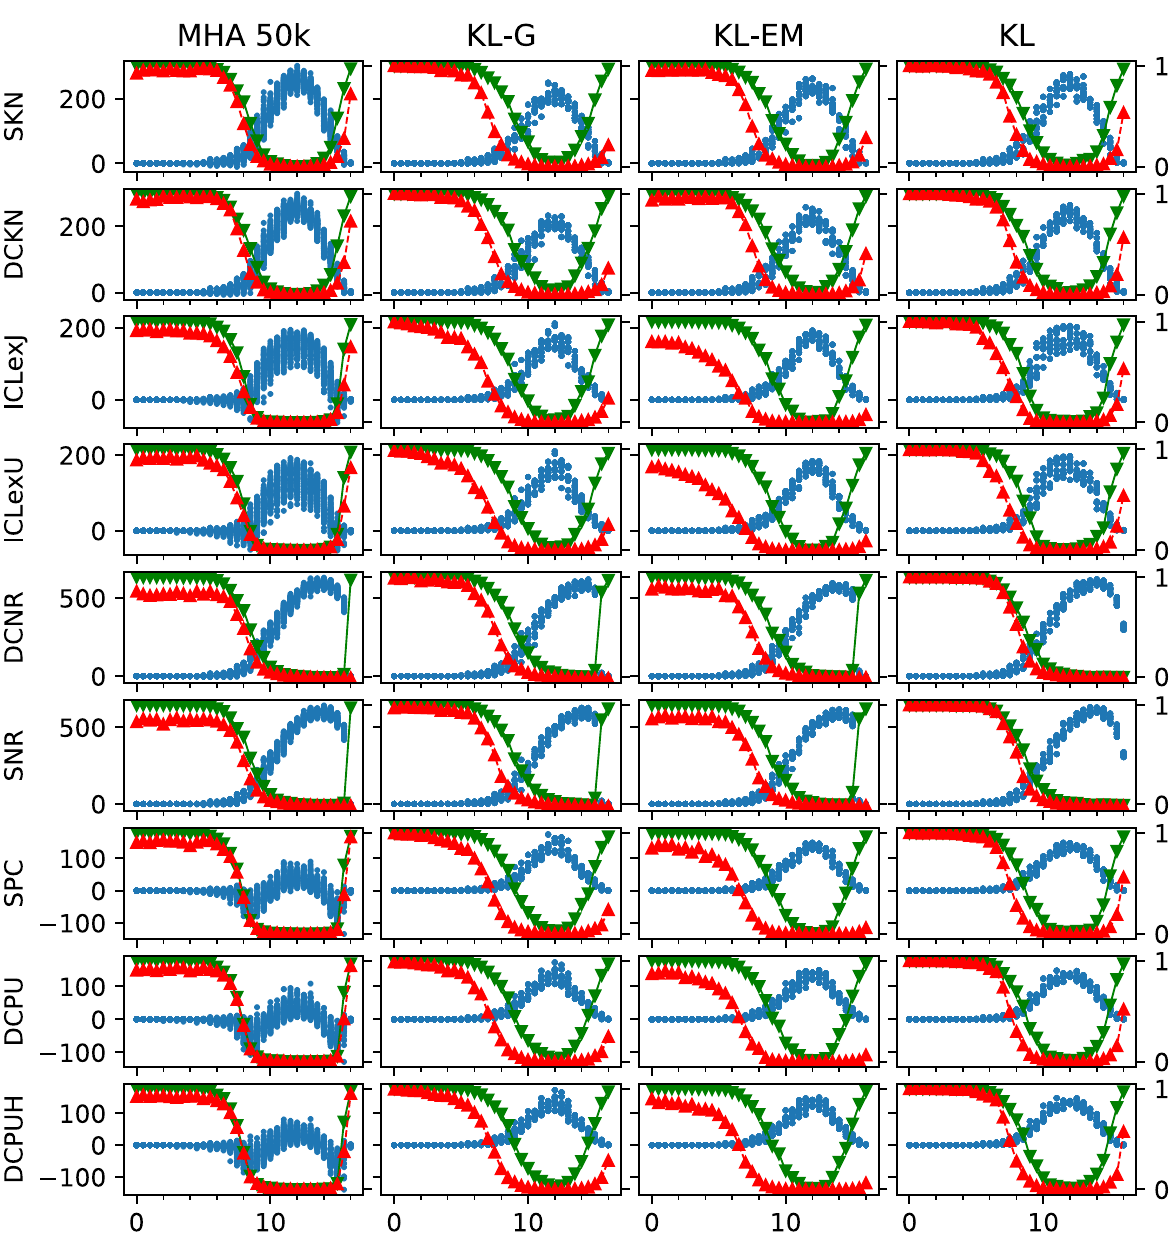
Fig 6. Results from starting the inference algorithms from the true partition 10 times for 10 network instances for each k out = 0, 0.5, ... , 16. The resulting difference to the original value (designated with a blue dot ● ), the average AMI of all runs of all network with the same parameter (represented with green triangles upside down ▼ ) and for comparison the average in the same manor reached from a random starting partition with the known number of groups (designated with red triangles ▲ ) are shown. The AMI values ( ▼ , ▲ ) of each row are visualized according to the right axis of each row. The difference of the objective functions we calculate with P observed − P true and is measured according to the left axis in each row. If the regarded model describes a likelihood, positive values represent more likely partitions then the planted partition. Each small diagram contains the values of the model of its row and the inference algorithm of its column. To reduce the total number of diagrams shown only the results of the Metropolis-Hastings algorithm with 50 000 steps is shown. Because PAH is not designed to start from a given partition, it is not included,